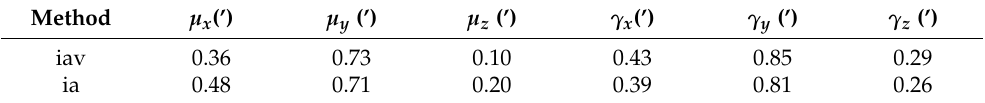
γ in the cases of the initial misalignment angles T [0.5 0.5 10 ] z